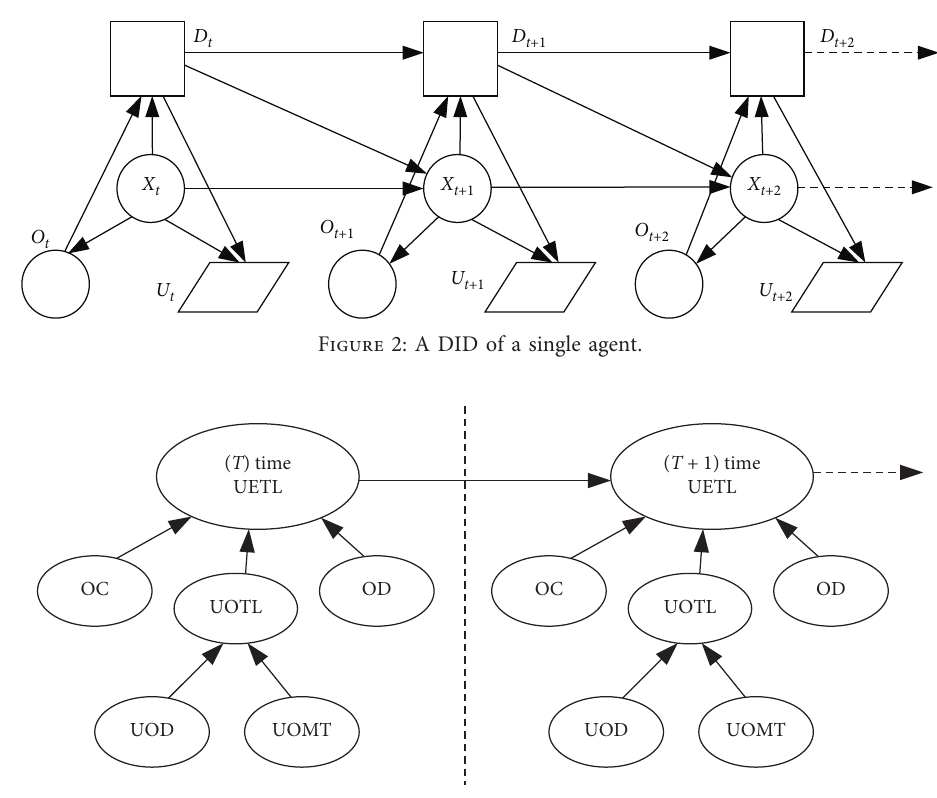
Figure 3: The threat assessment dynamic model for the underwater environment.